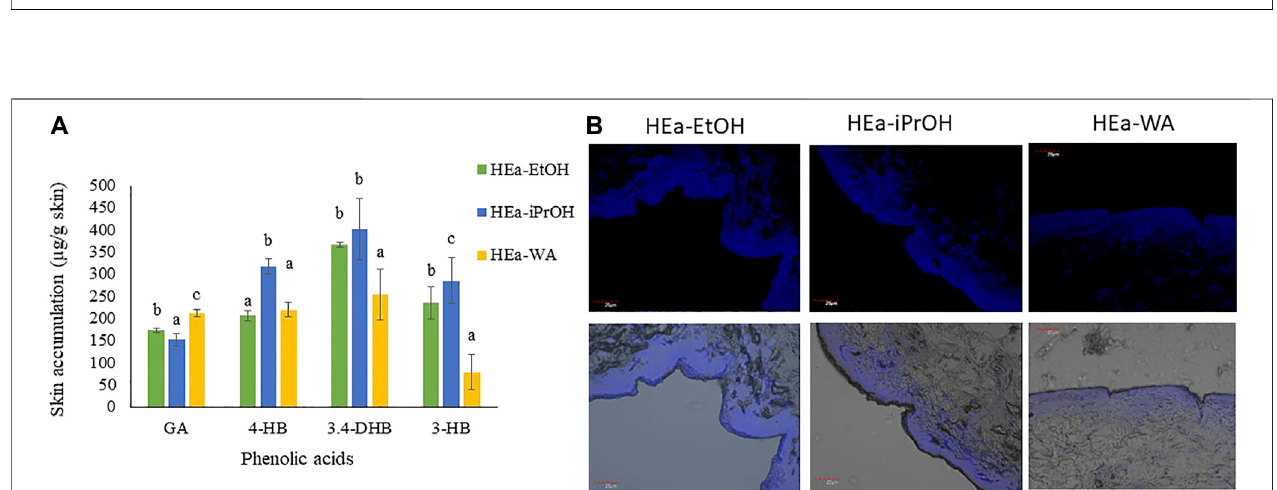
FIGURE 7 | Accumulation in the skin of phenolic acids after 24-penetration; different letters indicate signi fi cant differences between the HEas, α = 0.05 (A) . The microscopic photos of vertical slicing of porcine pig skin sections 24 h after applying the HEas. The polyphenols are visible in the upper layer of the skin, along the SC. Visible are the polyphenols blue under a fl uorescence effect (blue color) (B) . HEa-EtOH — hydrogel containing dry ethanolic extract of E. angustifolium; HEa- iPrOH — hydrogel containing dry isopropanol extract of E. angustifolium, HEa-WA-hydrogel containing dry water extract of E. angustifolium .